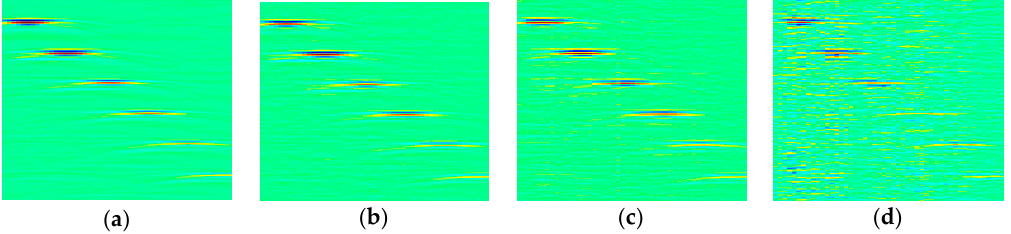
Figure 15. ( a ) The original experimental through-holes image of 50 MHz SR and the reconstructed results in time domain; ( b ) CR = 50%, PSNR = 45.36 dB; ( c ) CR = 60%, PSNR = 41.25 dB; ( d ) CR = 70%, PSNR = 34.45 dB.